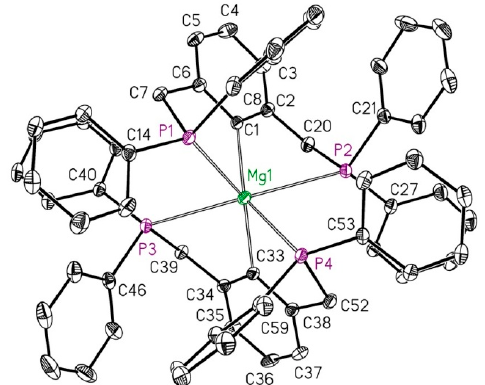
Figure 3. Molecular structure and atom numbering scheme of bis(2,6-bis(diphenylphosphanyl- methyl)phenyl)magnesium ( 2 ). The ellipsoids represent a probability of 30%; H atoms are omitted